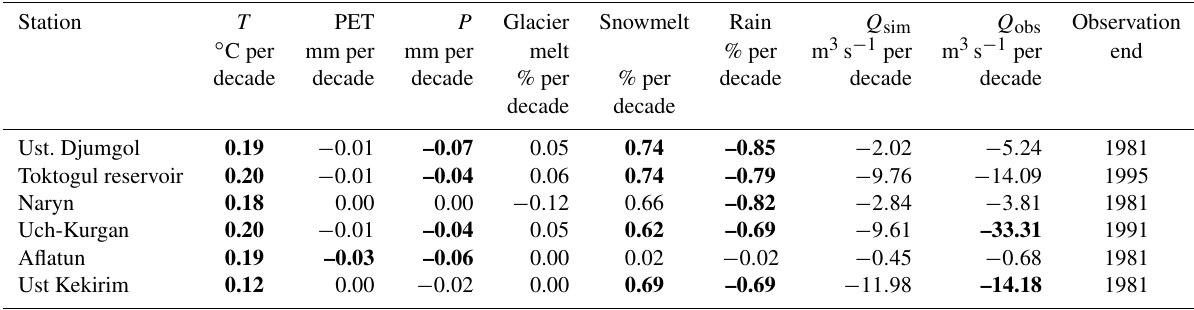
Table 7. Trends in annual air temperature, PET and precipitation and the fraction of annual runoff from snowmelt, glacier melt and rainfall for the period 1951–2007. Trends are derived for the 50th percentile experiment using a Mann–Kendall test with Sen’s slope estimator. Bold font indicates statistically significant trends with p values ≤ 0.05. Trends in annual simulated and observed discharge are also shown for the period 1951 to a variable end date which is dependent on the available observations.